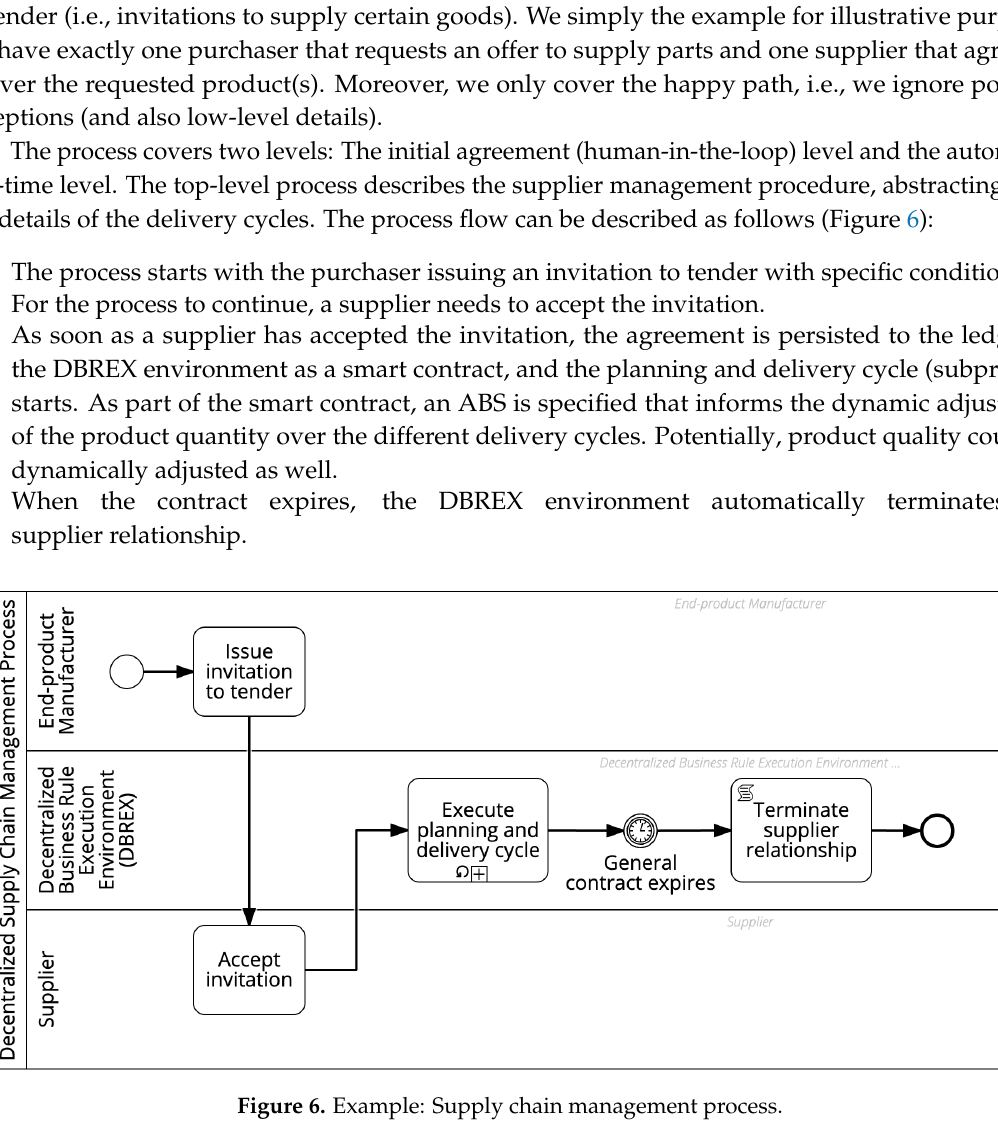
Figure 6. Example: Supply chain management